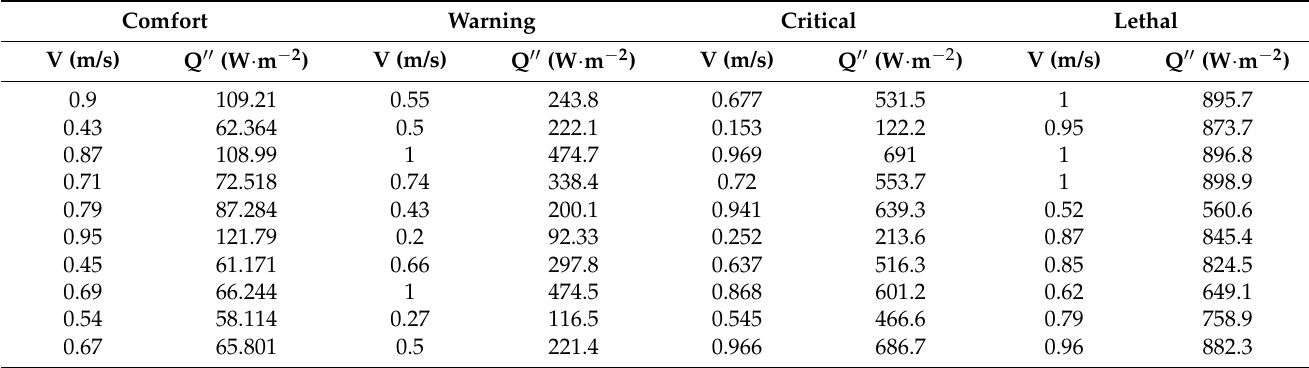
Table 3. Results of BO inverse mapping to estimate input parameters for T = 300 k, RH = 15% and various ECI max ( kJ/kg ) = 43 (comfort); 53 (warning); 63 (critical); and 73 (lethal).